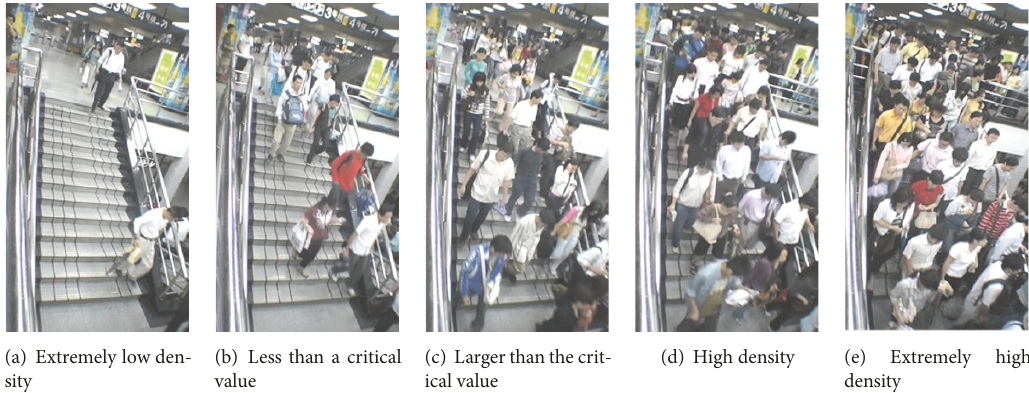
Figure 7: Illustrations of unidirectional stairway traffic at different density levels.